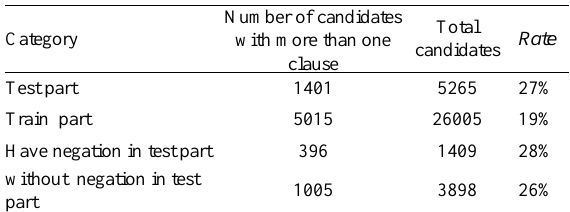
Table 1. Statistics of the ddi candidates with more than one clause in negddi-drugbank.